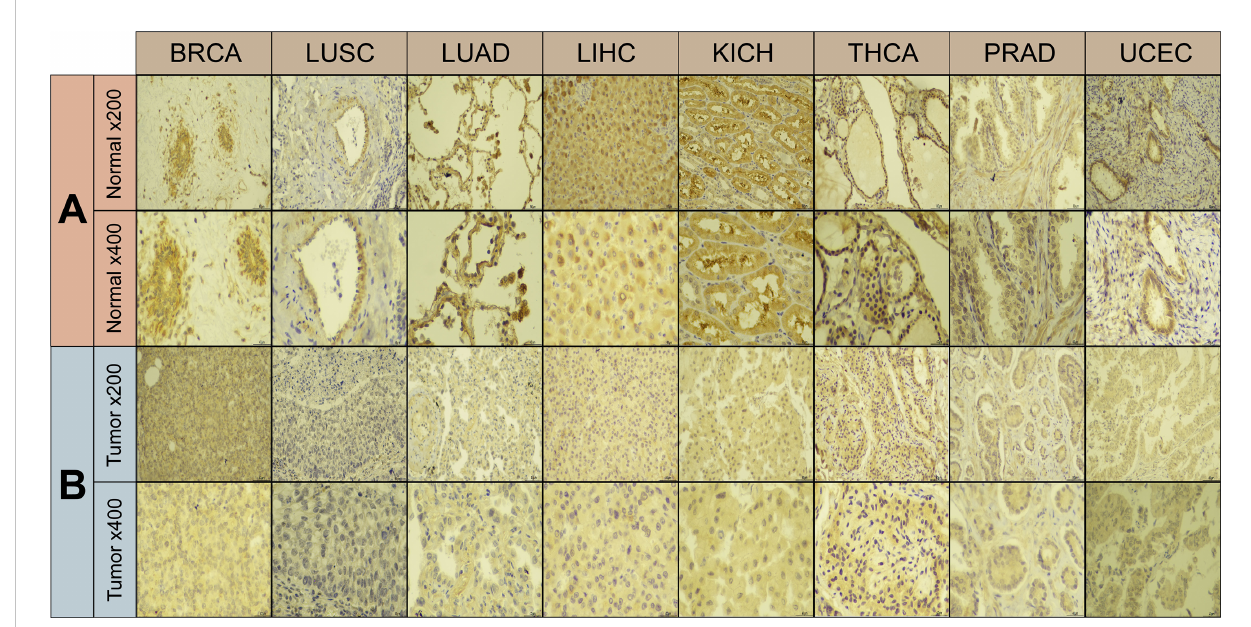
FIGURE 2 Immunohistochemical results of ABI3BP. (A, B) ABI3BP protein expression levels in BRCA, LUAD, LUSC, LIHC, KICH, THCA, PRAD, UCEC and corresponding normal tissues. Original magni fi cation, ×200 and